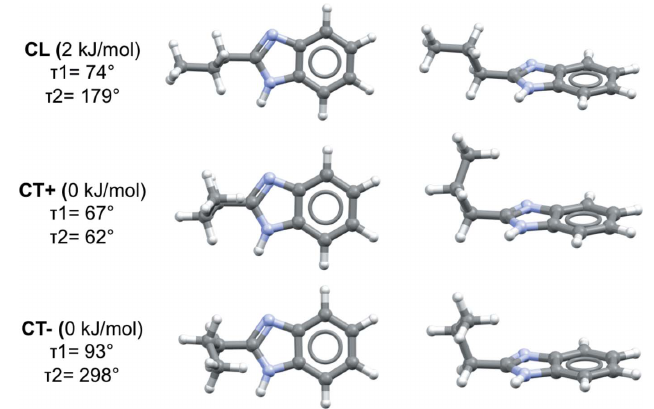
Figure 4 Conformational PES (B97d/6-311G**) of 2PrBzIm as a function of torsion angles (cid:3) 1 and (cid:3) 2 . Positions of conformers CL, CT+ and CT (cid:4) are labelled.